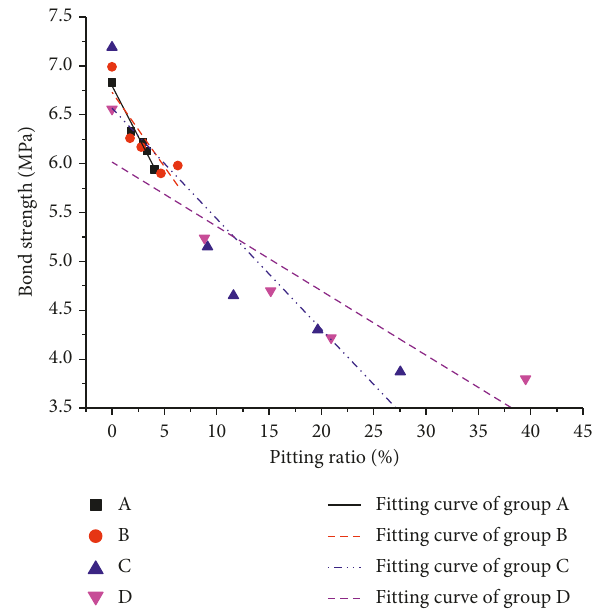
Figure 13: The linear fitting curve of the pitting corrosion ratio and the maximum bond